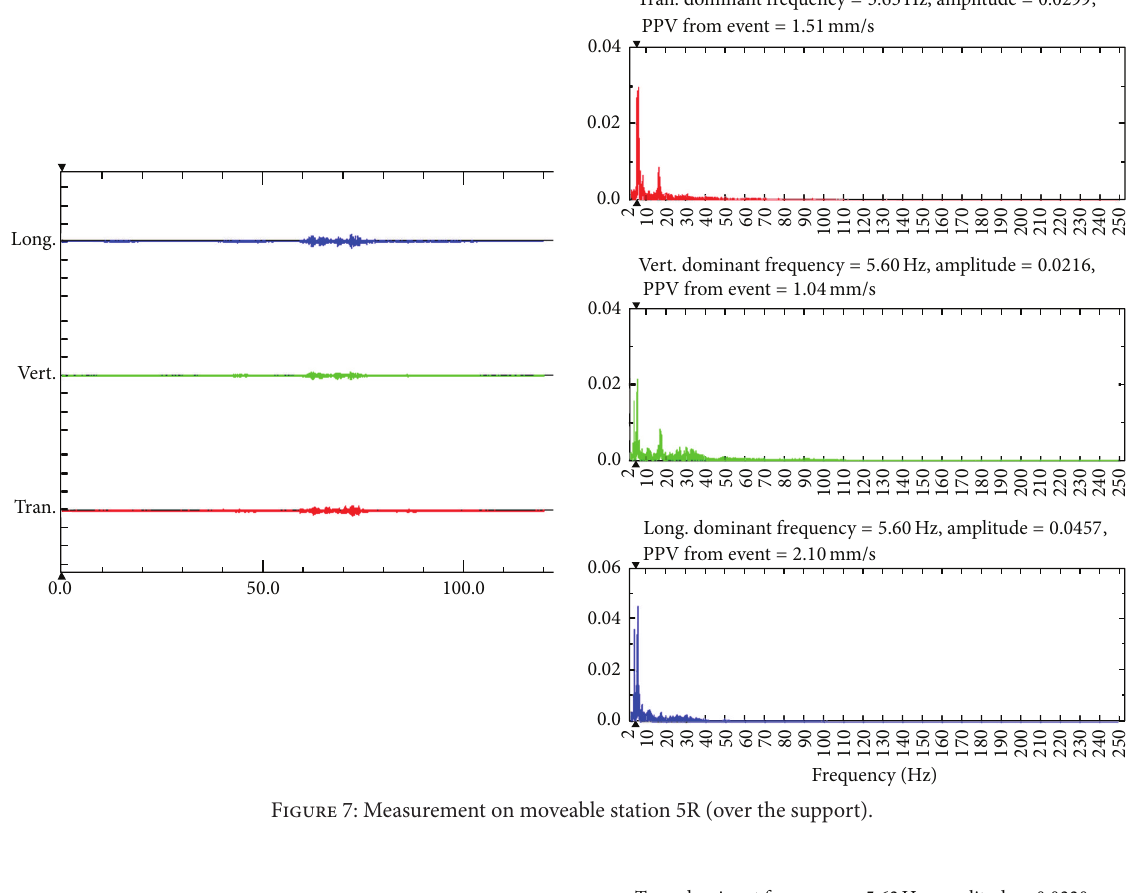
Figure 7: Measurement on moveable station 5R (over the support).